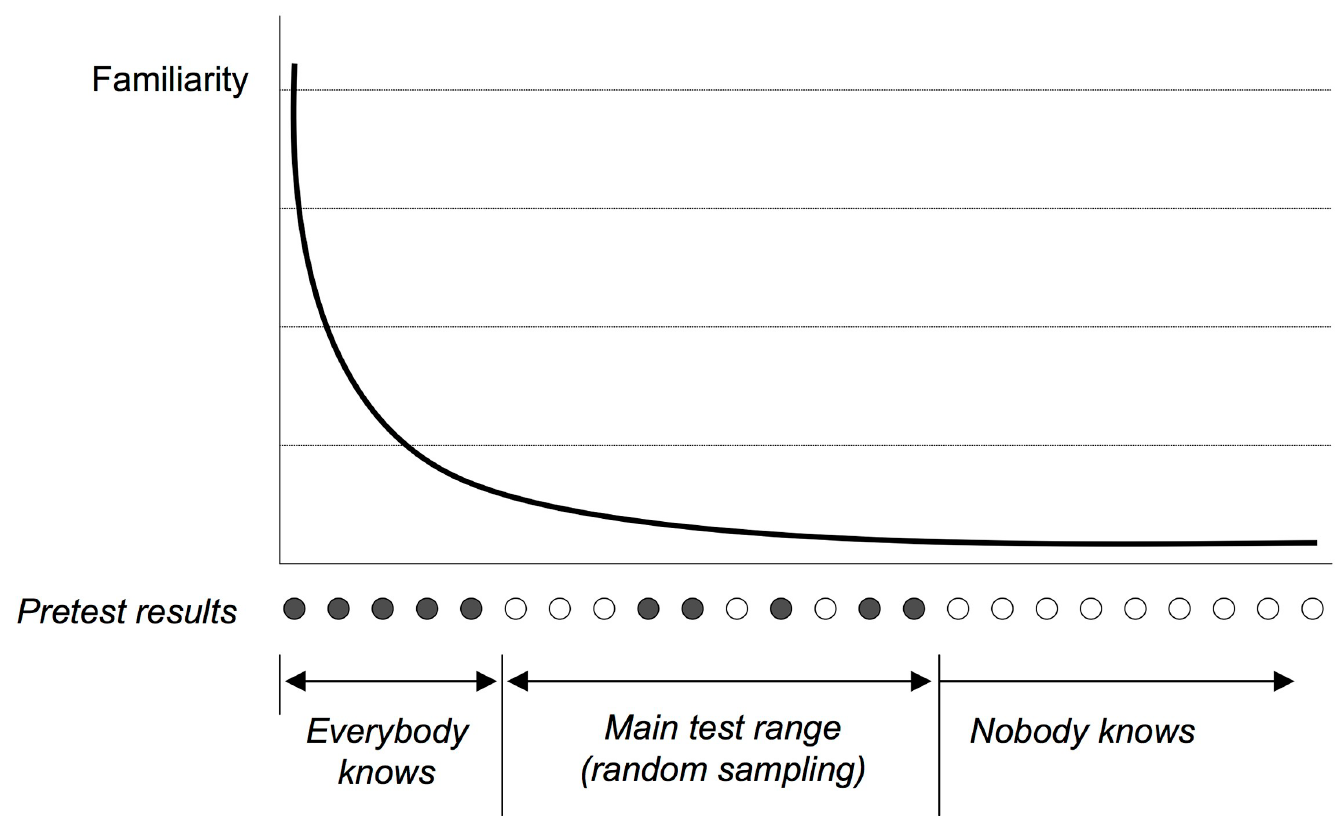
Fig 1. Disease familiarity distribution, showing the disease knowledge